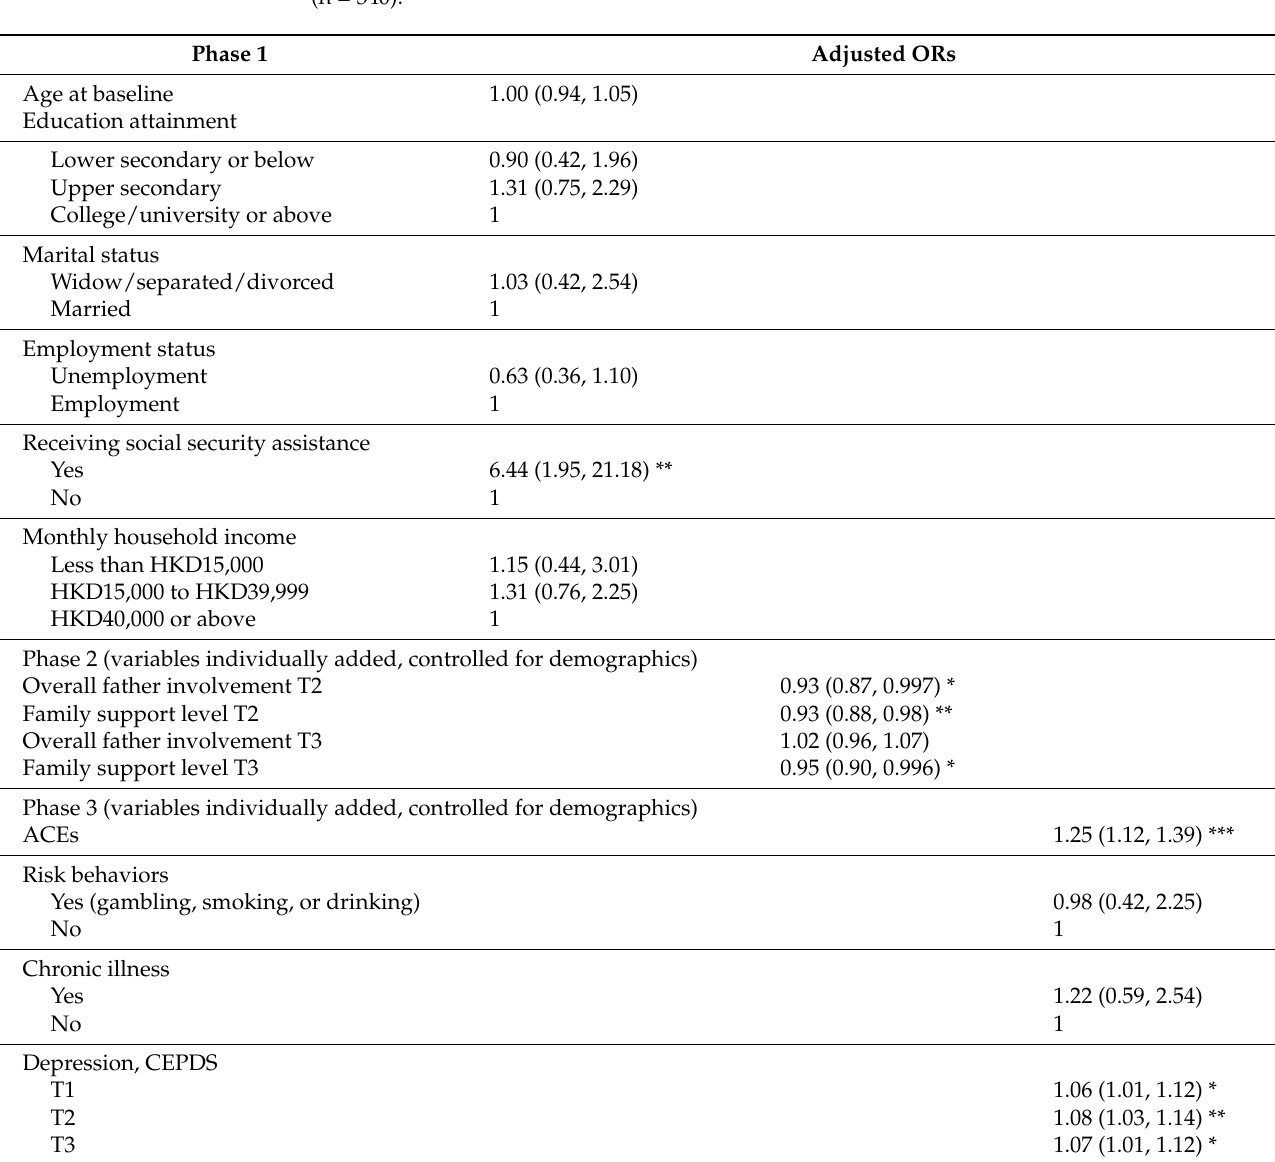
Table 3. Adjusted Odds Ratios (ORs) and 95% Confidence Intervals (CIs) of Variables Obtained in the Multiphase Ordinal Logistic Regression using Type of Relationship as the Dependent Variable (n =